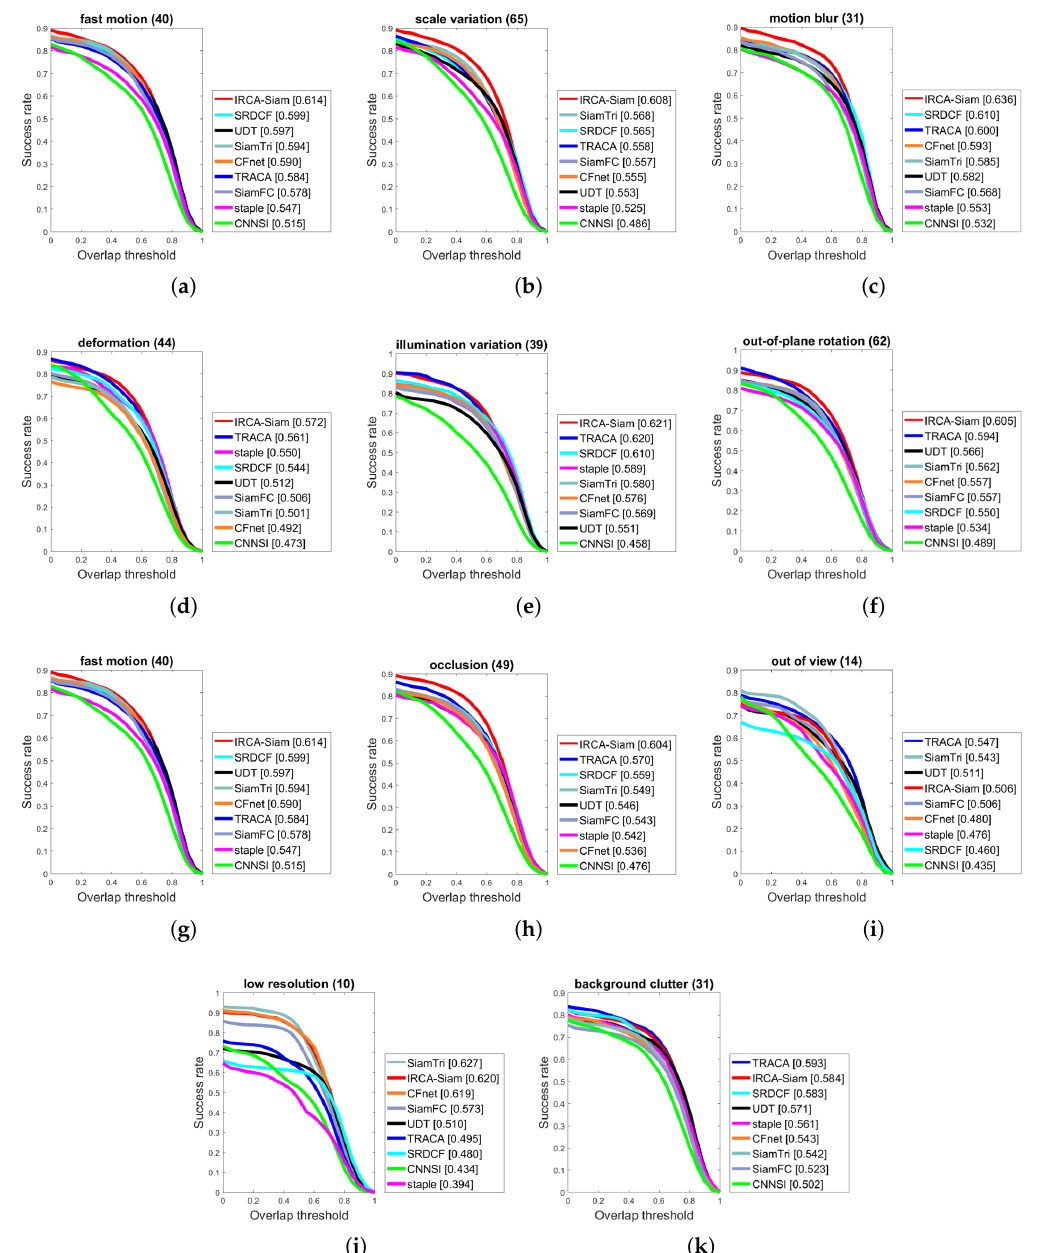
Figure 4. Success plots over OTB2015 for different challenges such as ( a ) fast motion, ( b ) scale variation, ( c ) motion blur, ( d ) deformation, ( e ) illumination variation, ( f ) out-of-plane rotation, ( g ) fast motion, ( h ) occlusion, ( i ) out-of-view, ( j ) low resolution, and ( k ) background